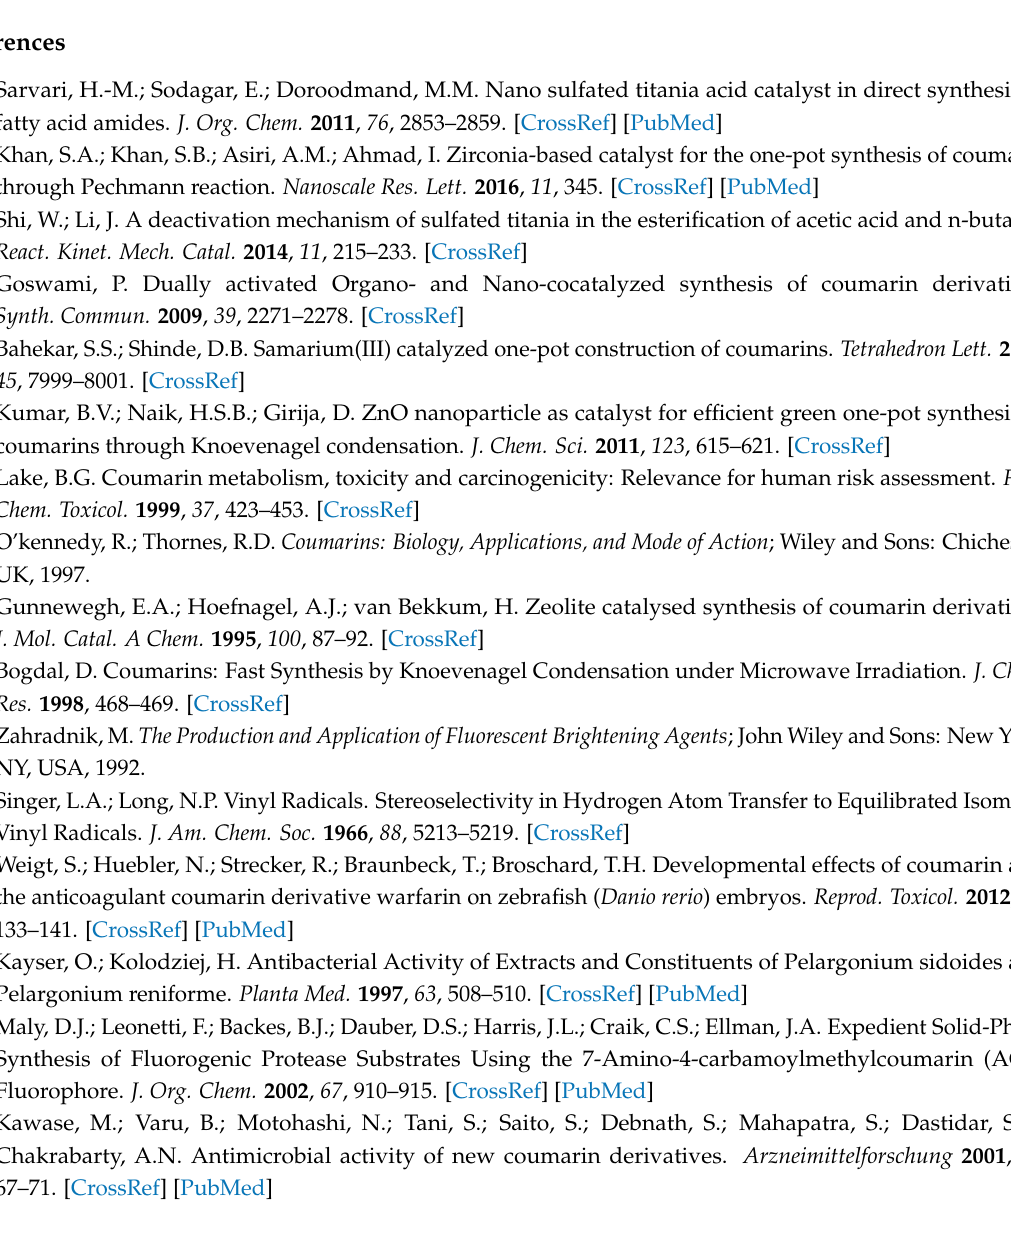
Figure S1: FTIR spectra of: (A) SiO 2 and treated with sulfuric acid SiO 2 -S and phosphoric acid SiO 2 -P, (B) TiO 2 and its treatment with sulfuric acid TiO 2 -S and phosphoric acid TiO 2 -P, and (C) silica prepared from TEOS treated with sulfuric and phosphoric acid calcined at 450 and 650 ◦